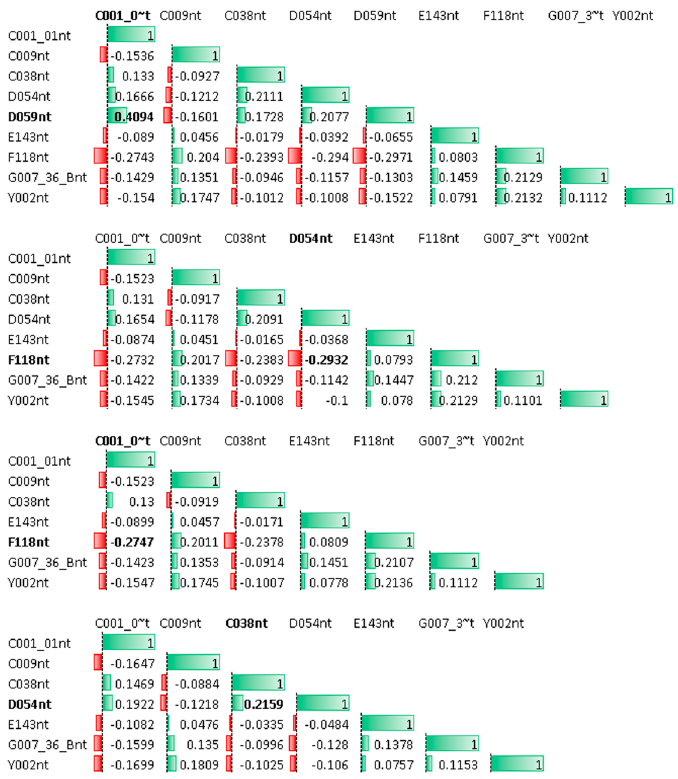
Figure 2. Assessing collinearity using consecutive matrices with correlation coefficients only for predictors (Stata script at https://tinyurl.com/ueefxfmd, accessed on 30 January 2023).